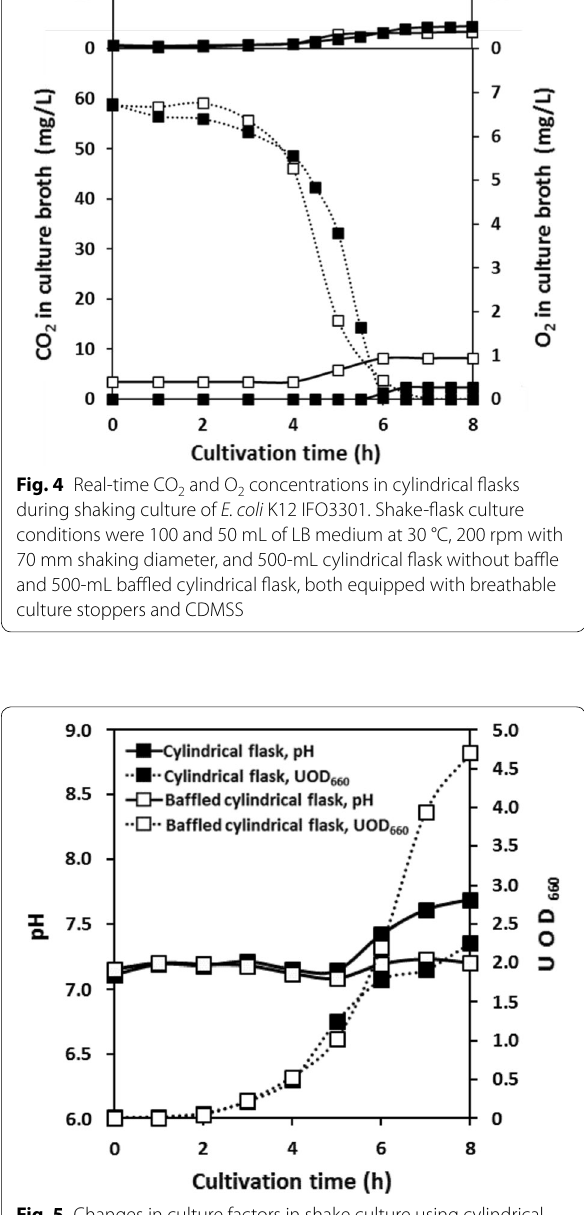
Fig. 5 Changes in culture factors in shake culture using cylindrical flask and baffled cylindrical